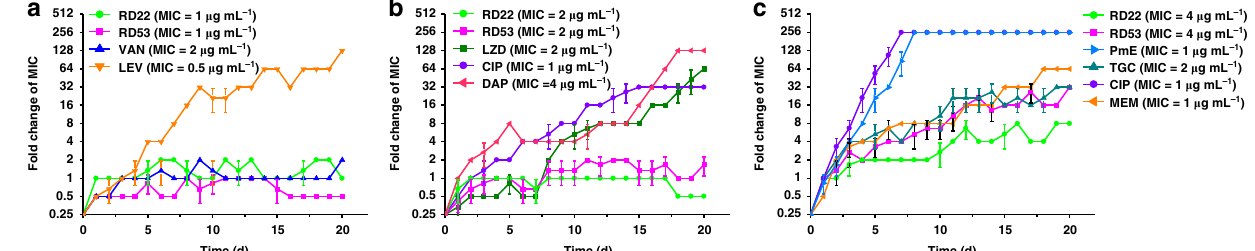
Fig. 5 Resistance acquisition of pathogens during serial passaging in sub-MIC levels of antimicrobials. The y axis is the fold change of MIC. a MRSA (ATCC43300) towards RD22 (MIC = 1 μ g mL − 1 , tested up to 2 × MIC), RD53 (MIC = 1 μ g mL − 1 , tested up to 1 × MIC), levo fl oxacin (MIC = 0.5 μ g mL − 1 , tested up to 128 × MIC), and vancomycin (MIC = 2 μ g mL − 1 , tested up to 2 × MIC). b VRE (ATCC51299) toward RD22 (MIC = 2 μ g mL − 1 , tested up to 1 × MIC), RD53 (MIC = 2 μ g mL − 1 , tested up to 2 × MIC), linezolid (LZD, MIC = 2 μ g mL − 1 , tested up to 64 × MIC), cipro fl oxacin (CIP, MIC = 1 μ g mL − 1 , tested up to 32 × MIC), and daptomycin (DAP, MIC = 4 μ g mL − 1 , tested up to 128 × MIC). c A. baumannii (ATCC19606) toward RD22 (MIC = 4 μ g mL − 1 , tested up to 8 × MIC), RD53 (MIC = 4 μ g mL − 1 , tested up to 32 × MIC), polymyxin E (PmE, MIC = 1 μ g mL − 1 , tested up to 256 × MIC), tigecycline (TGC, MIC = 2 μ g mL − 1 , tested up to 32 × MIC), and cipro fl oxacin (CIP, MIC = 1 μ g mL − 1 , tested up to 256 × MIC), meropenem (MEM, MIC = 1 μ g mL − 1 , tested up to 64 × MIC). Data are representative of three independent experiments. Error bars indicate